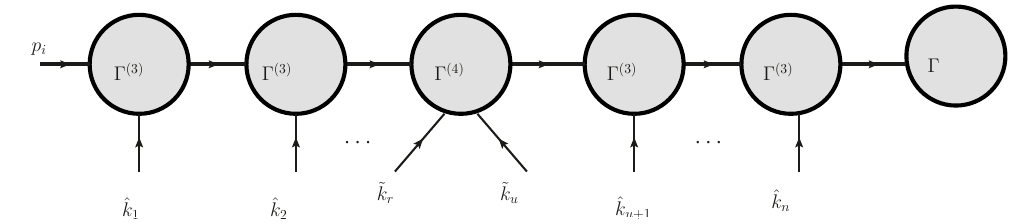
Figure 13 . Diagram contributes in subleading order with two of the soft particles attached via (cid:0) (4) vertex.